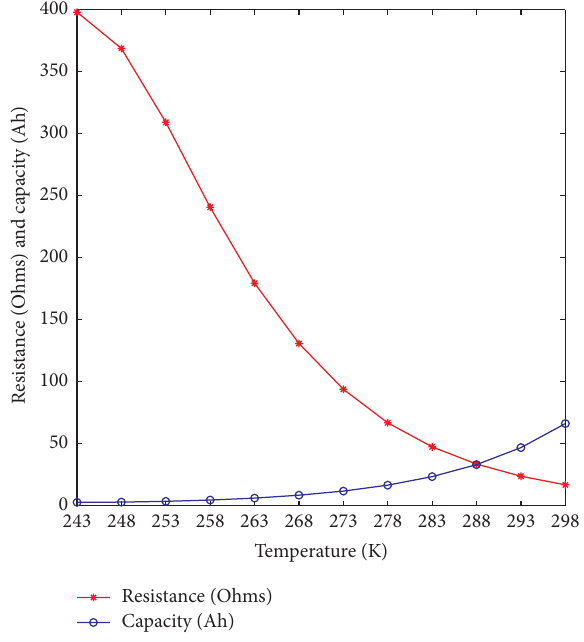
Figure 7: Resistance and capacity variation with temperature. Table 3: Fuel economy comparison chart for SOC